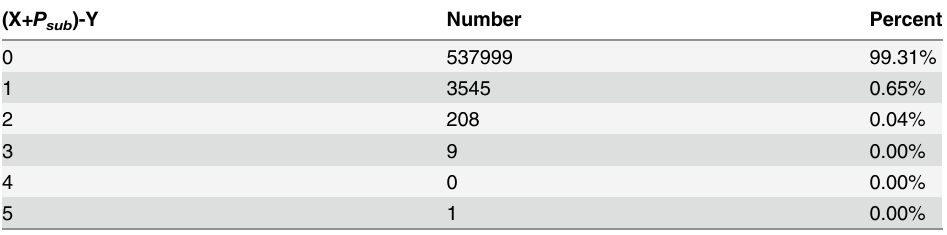
Table 7. A check on the non-independence of PTM counting on the unique amino acid count carried out on P sub as described in Methods, Extracting unique amino acid counts in Selene. (X+ P sub